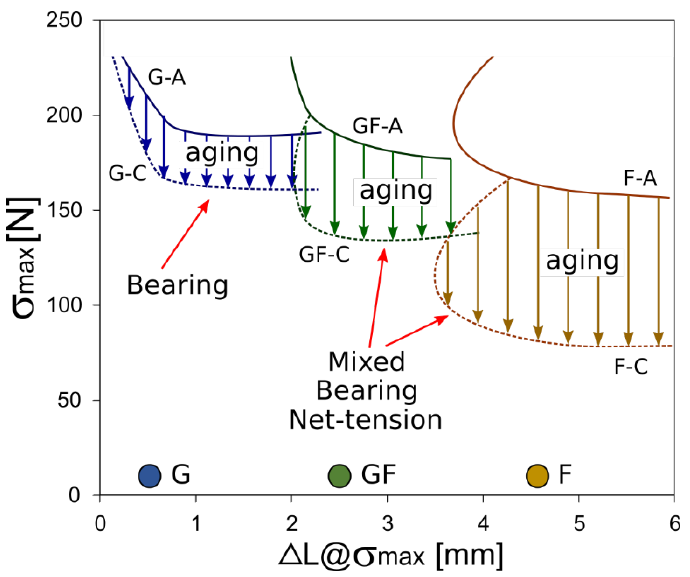
Figure 8. Bearing failure mechanism modification due to aging in σmax vs ΔL@σ max plot at varying stacking sequence.